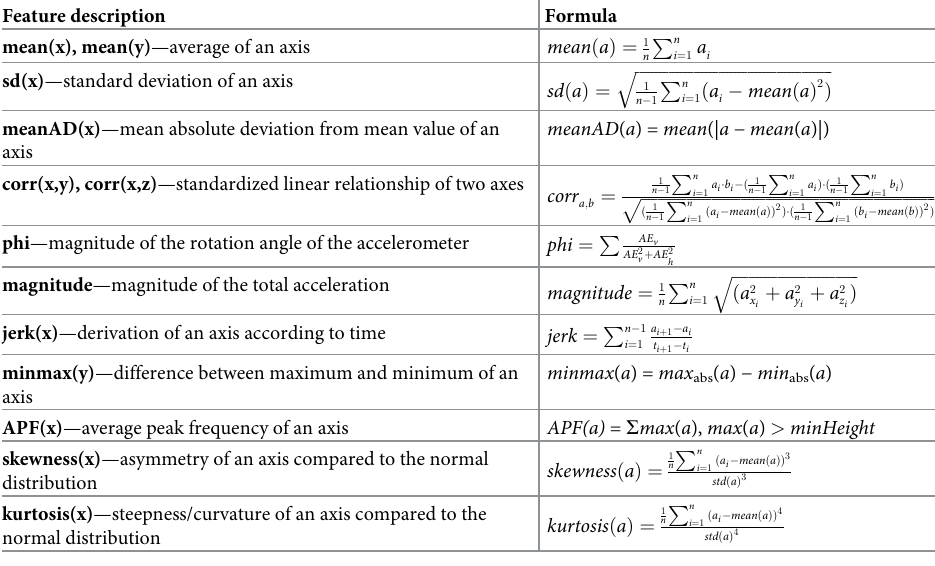
Table 2. Description of selected features for activity